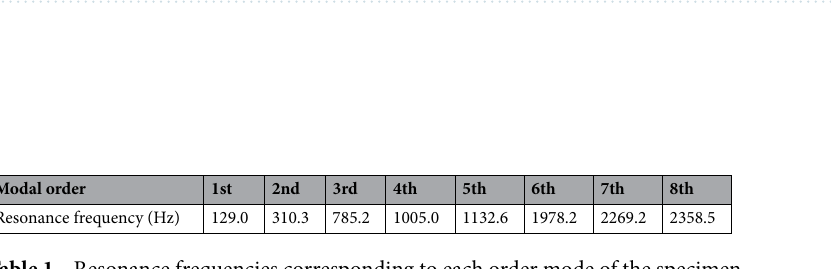
Table 1. Resonance frequencies corresponding to each order mode of the